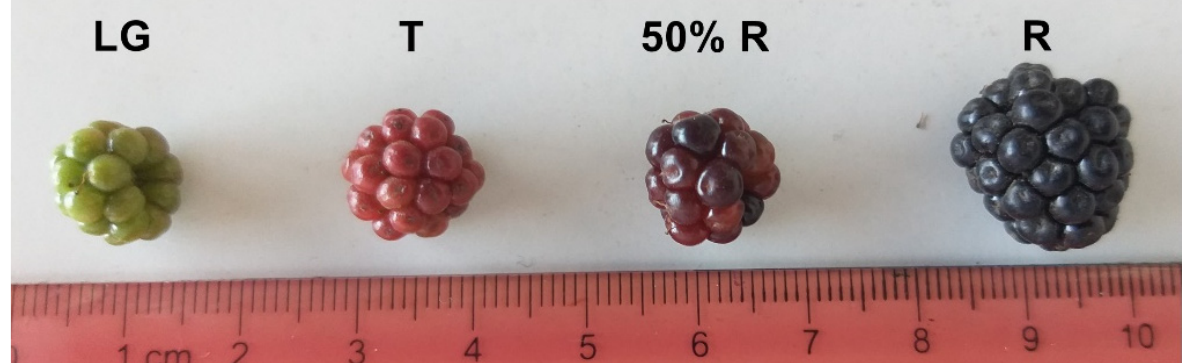
Figure 1. Different ripening stages of R. ulmifolius Schott fruits: large green fruit (LG); turning fruit (T); 50% black fruit (50%R); and ripe black fruit (R). Fruits obtained during the summer of 2019.